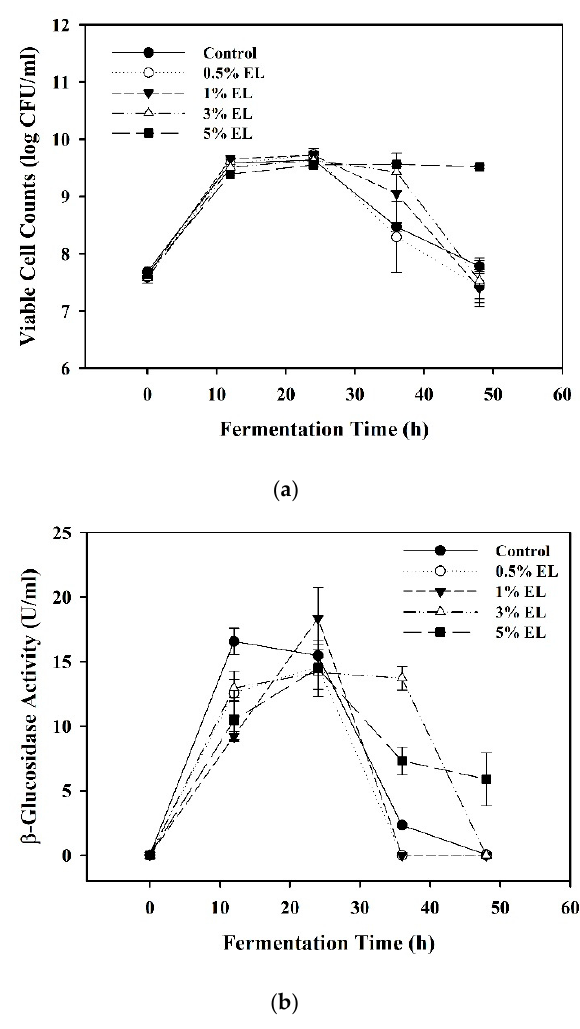
Figure 1. Effect of various percentages of E. serratus leaves (EL) in MRS on the growth of L. plantarum : ( a ) viable cell counts vs. fermentation time; ( b ) β -glucosidase activity vs. fermentation time. The data were expressed as mean ± standard deviations ( n = 3).